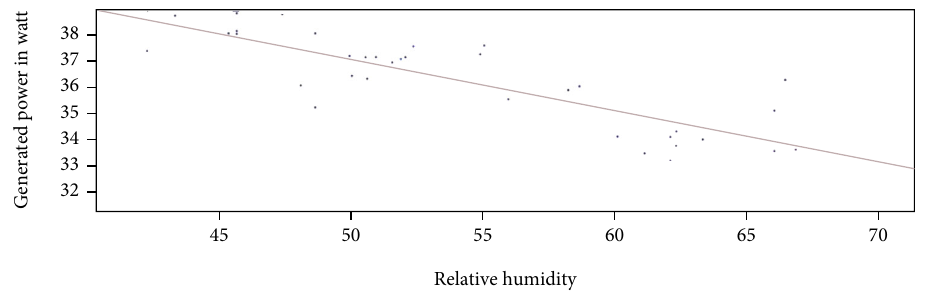
Figure 23: LR between generated power and relative humidity.